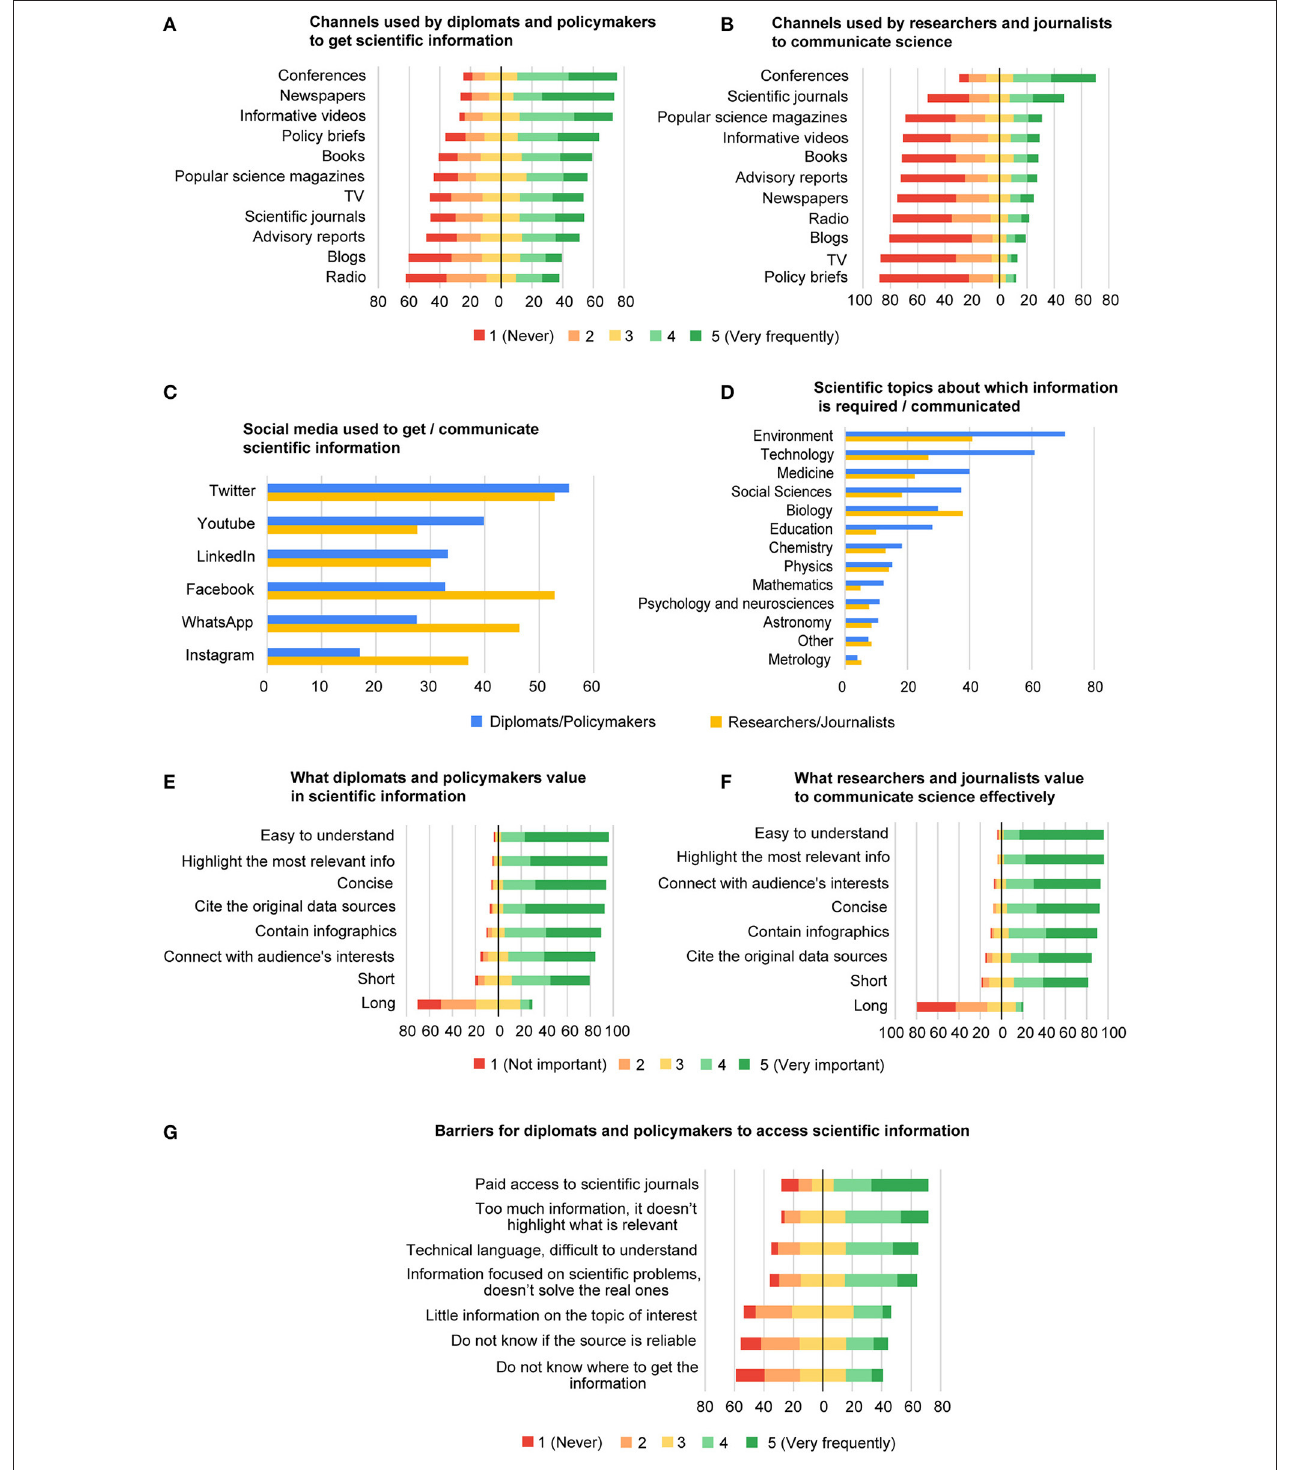
FIGURE 2 | (A) Frequency at which diplomats and policymakers use various communication media to obtain information on scientific and technological advances, in their work. (B) Frequency at which researchers and science journalists communicate science on various communication media. (C) Preferred social media to get scientific information (diplomats and policymakers, blue) and to communicate science (researchers and science journalists, yellow). (D) Scientific topics about which diplomats and policymakers need information (blue) and researchers and science journalists focus on when communicating (yellow). (E) What diplomats and policymakers value more or less in science information. (F) Factors, the researchers and science journalists think are more or less important for effective science communication. (G) Frequency at which diplomats and policymakers face different barriers when trying to acquire scientific information. All data are shown in percent.